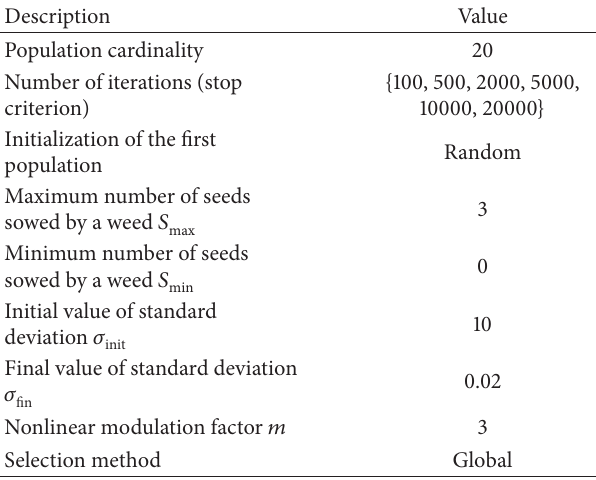
Table4:TheparametersofIWOusedforminimizationofGriewank and Rastrigin functions.